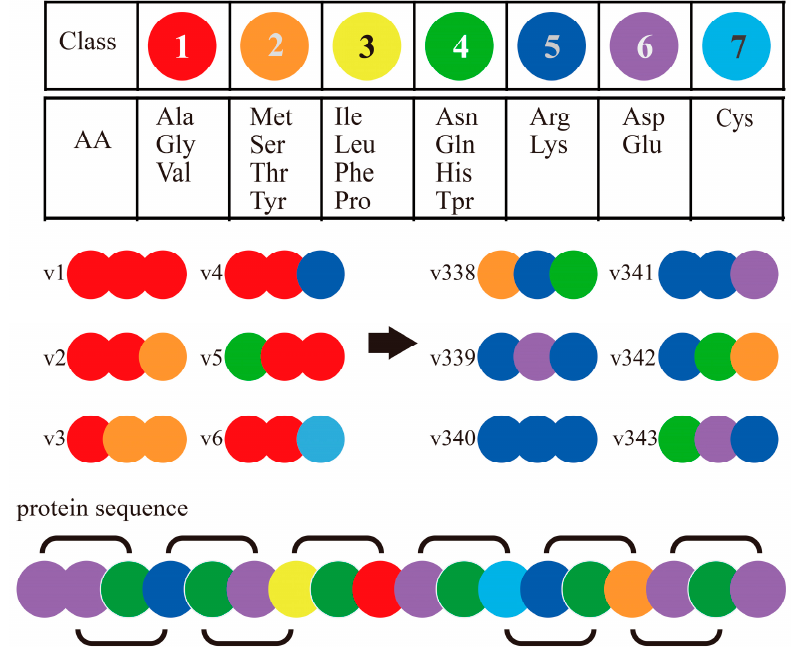
Figure 3. Schematic diagram for Conjoint Triad Method [55].